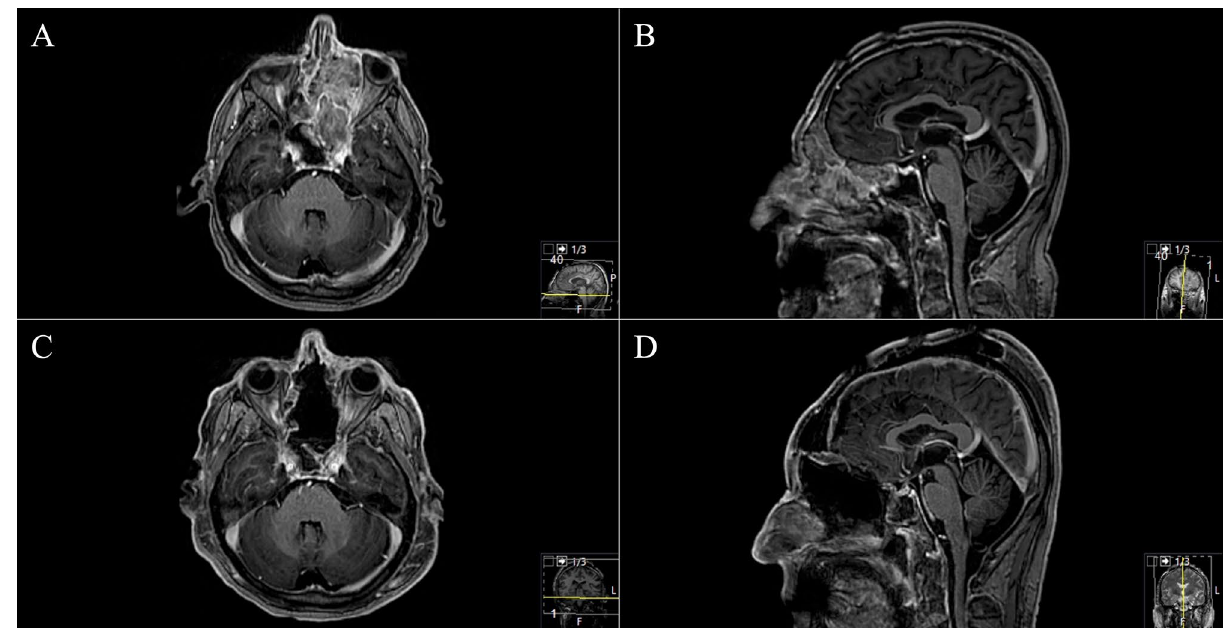
Figure 2. Exemplary case 2: a 70-year-old male patient presented with recurrent left eye inflammations and swelling over medial canthus. Ophthalmic examination revealed obstructed nasolacrimal ductus. ( A , B ) Preoperative T1-weighted gadolinium-enhanced MR imaging showing sinonasal and left orbit-infiltrating tumor. Ethmoidal and sphenoid sinus are completely infiltrating. Left bulbus is suppressed. ( C , D ) Postoperative MR control showing successful resection. Orbit, sphenoid and tuberculum sellae reconstructions were performed with split-bone graft, galea-periosteum flap and fibrin glue. Pathologic findings revealed metastasis of malign melanoma. The patient underwent endoscopic transnasal, sublabial reresection in the subsequent course.